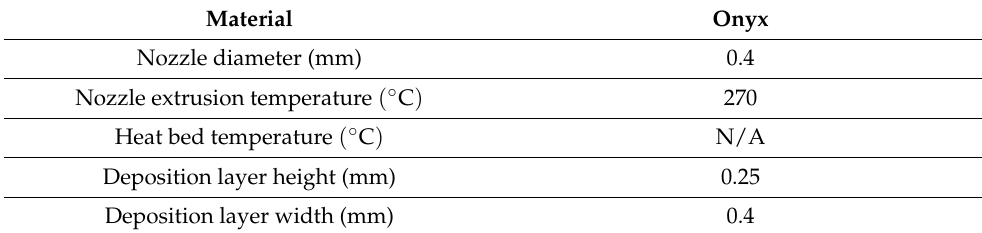
Table 1. FFF 3D printing parameters of Onyx specimens.